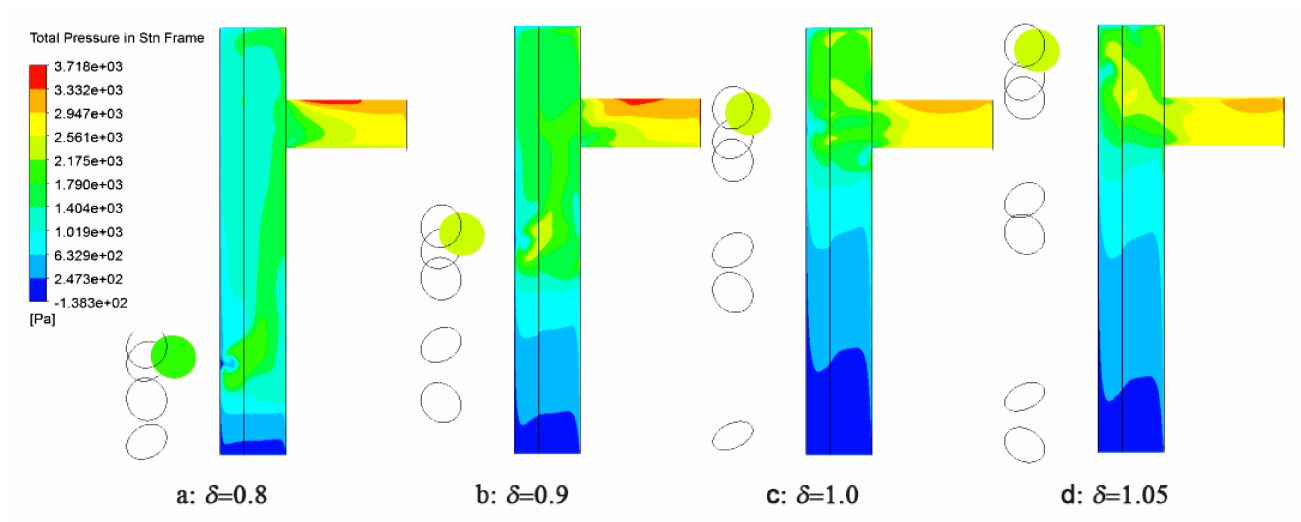
Figure 22. Contour of total pressure in the static frame at plane θ = − 12 ◦ for different radius ratios of nozzles to holes: ( a ) δ = 0.8, ( b ) δ = 0.9, ( c ) δ = 1.0, ( d ) δ =